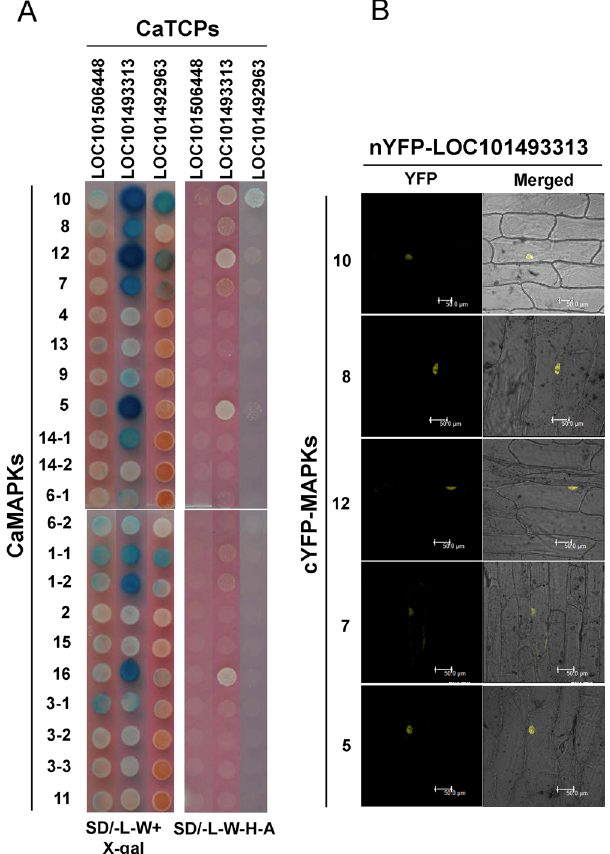
Figure 5. Interaction analysis of chickpea CaMAPKs with CaTCP transcription factors. ( A ) Y2H analysis of chickpea CaMAPKs with CaTCPs. Three members of class I TCP transcription factors from chickpea were fused with Cub-LexA-VP16 in pGDHB1vector and transformed in yeast strain NMY51. Chickpea MAPKs were fused with mNub in pGPR3-N vector and transformed in yeast strain NMY61. After mating and two round of selection, the yeast cells were spotted on SD/-L-W and SD/-L-W-H-A plates. Plates were photographed after 48 h growth and X-gal overlay assay was performed to check the activation of LacZ gene as third reporter. Yeast growth on SD/-L-W-H-A and blue colour after X-gal overlay assay suggests protein-protein interaction. ( B ) BiFC assay of five CaMAPKs and one CaTCP encoded by LOC101493313 . Independently five CaMAPKs were tagged with C-terminal half of YFP and CaTCP was tagged with N-terminal half of YFP. Plasmid DNA of a CaMAPK and CaTCP pair was precipitated on 1 µ m gold particles and bombarded on onion epidermal cells. The cells were observed under confocal microscope after 48 hours. In all five, YFP signal was visualised in nucleus. Scale bars, 50 µ